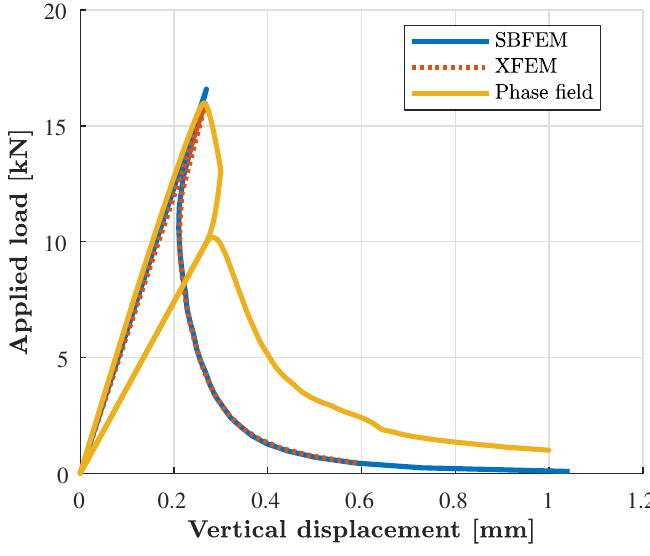
Figure 32. LSP load-deflection